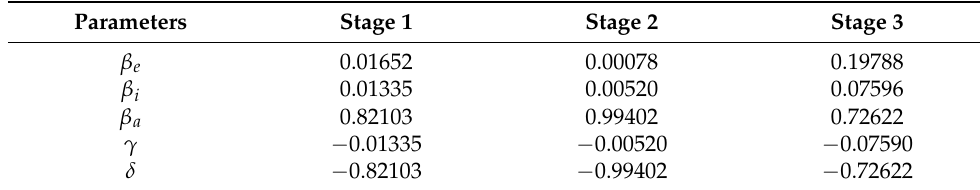
Table 2. Sensitivity indices of R 0 in response to the variation of model parameters using reported data in three